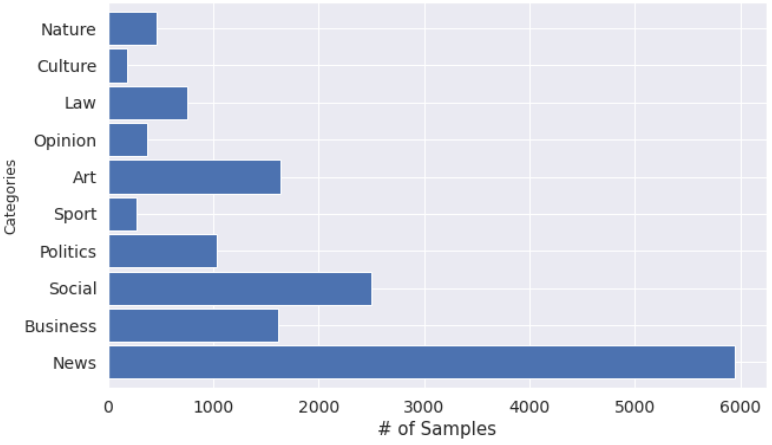
Figure 2. Distributions of Amharic user generated documents in each